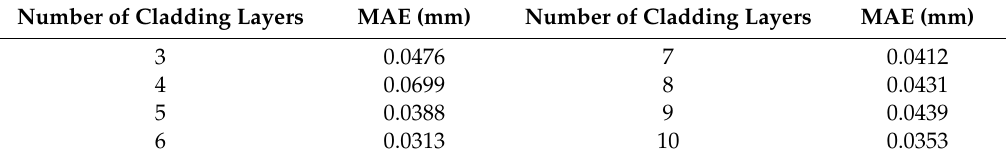
Table 5. Predicted precision of established model.